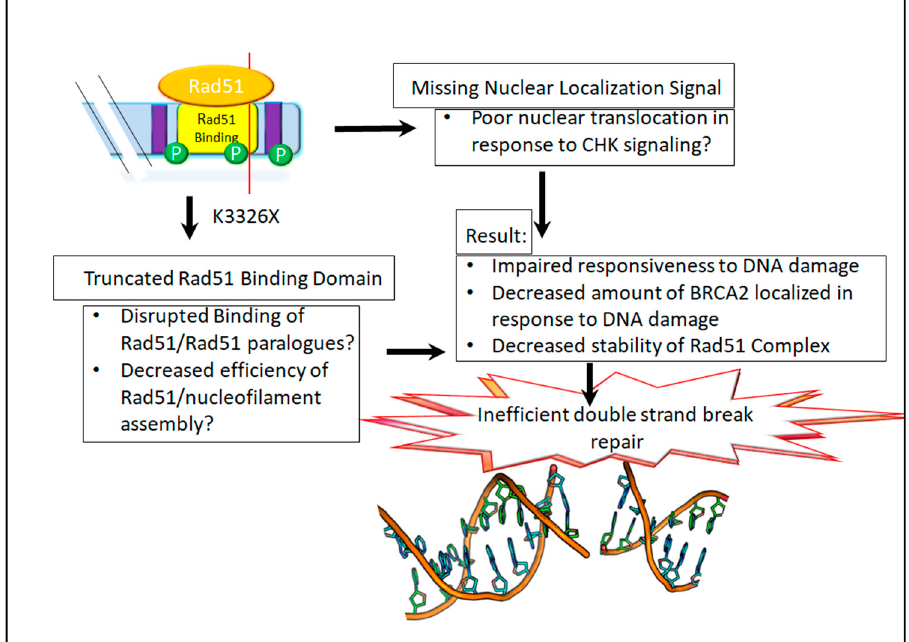
Figure 3. The K3326X mutation: The K3326X mutation results in the loss of the most distal 93 amino acids of the protein. This results in the loss of the final nuclear localization signal, the phosphorylated residue T3387, and the last four residues of the Rad51 binding site.